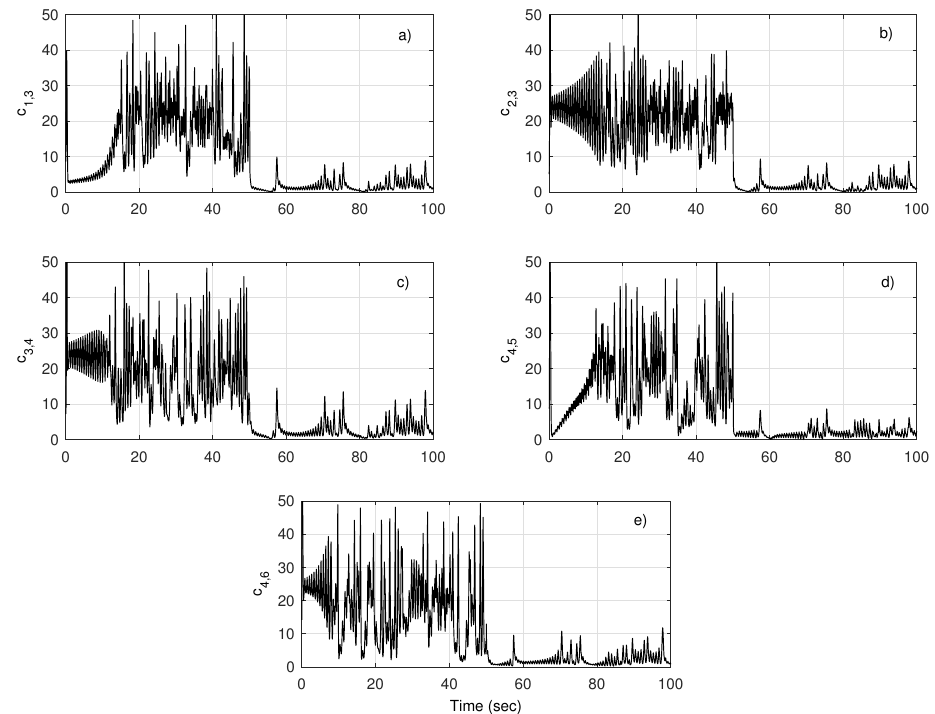
Figure 7. Time evolution of the endogenous couplings between the corresponding nodes. ( a ) Coupling force between node 1 and node 3, ( b ) Coupling force between node 2 and node 3, ( c ) Coupling force between node 3 with node 4 the central nodes and the more strong coupling, ( d ) Coupling force between node 4 and node 5, ( e ) Coupling force between node 4 and node